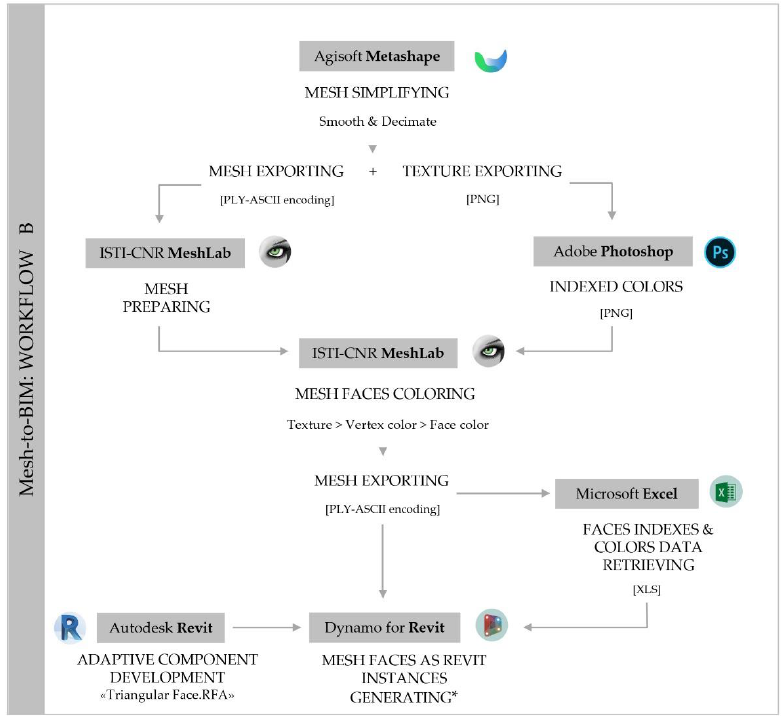
Figure 2. Procedural Workflow B scheme. (MESH FACES AS REVIT INSTANCES GENERATING*: resumes to the entire script described in Figure 3).